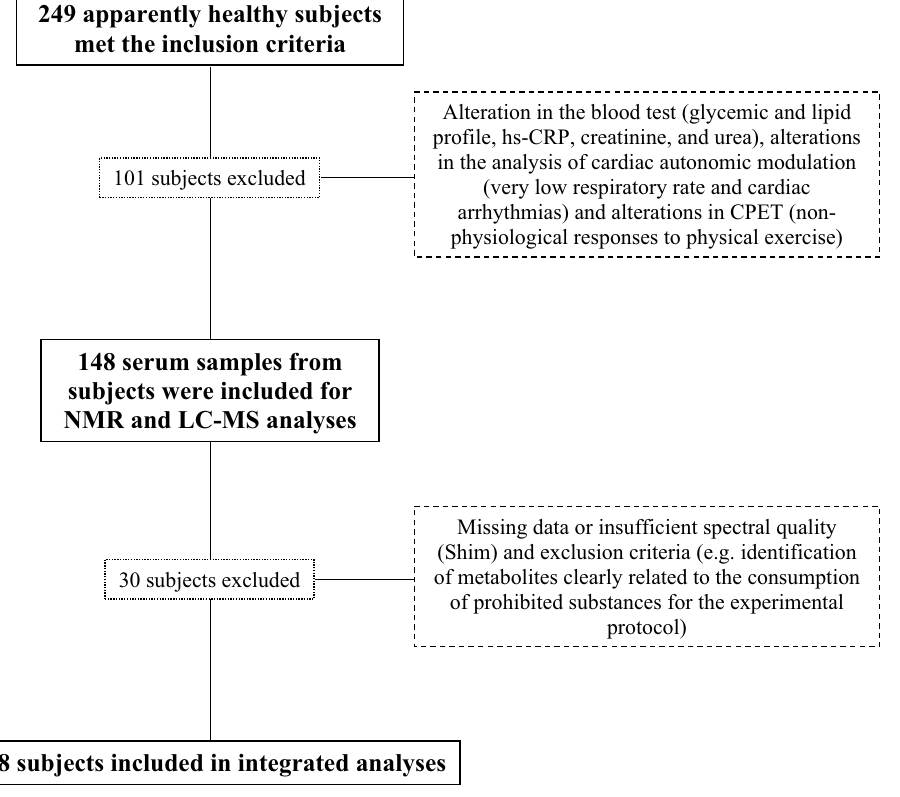
Figure 1. Loss flowchart. CPET cardiopulmonary exercise testing, hs-CRP high-sensitivity C-reactive protein, LC–MS liquid chromatography-coupled mass spectrometry, NMR nuclear magnetic resonance.